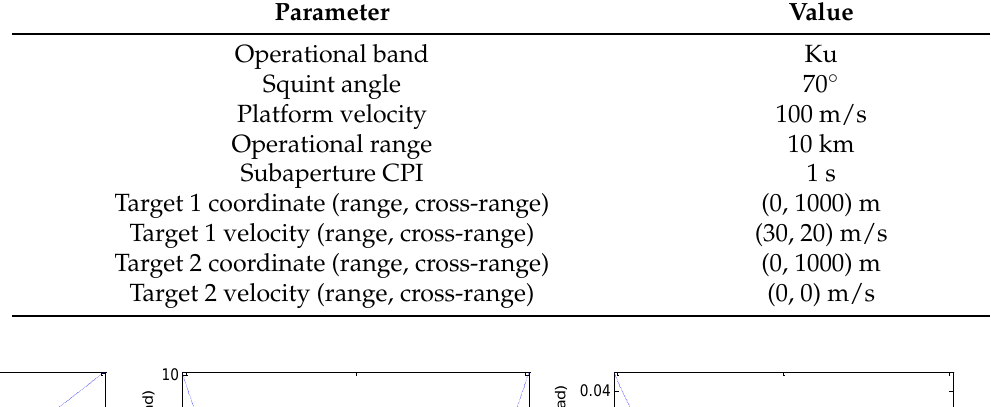
Table 1. Simulated parameters.